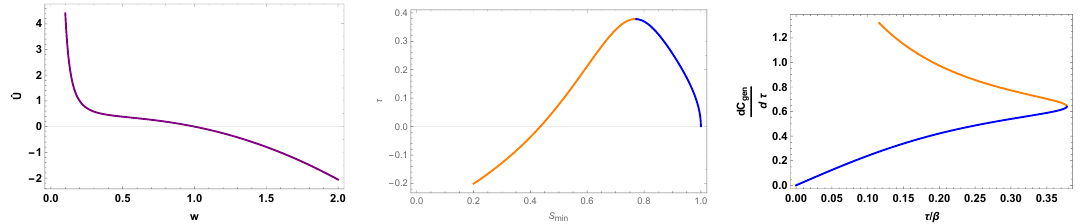
Figure 15 . The case d = 2 , θ = 0 , z = 1 and λ = 5 × 10 − 3 : Left ) The effective potential as a function of w . For this value of λ there are no maxima neither inside or outside the horizon. Middle ) . For each value of τ there are two values of r . Therefore, it is τ/β in terms of s min = r min min r h expected that there are two branches for d C gen which one of them should be unphysical. The blue dτ curve has larger values of r in comparison to the orange one. Moreover, according to figure 1, as min time passes r decreases. Therefore, the correct values of r are given by the blue curve. Right min min